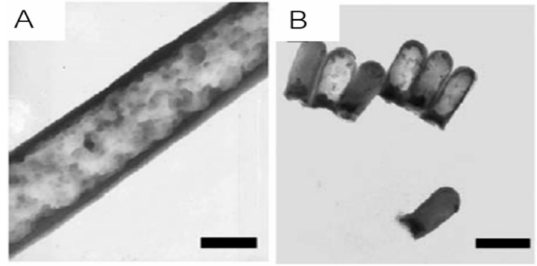
Figure 6. TEM images of 200 nm ( A ) and 60 nm ( B ) nanotubes with magnetite. Scale bars, 200 nm. Adapted from [147] with permission from Elsevier,